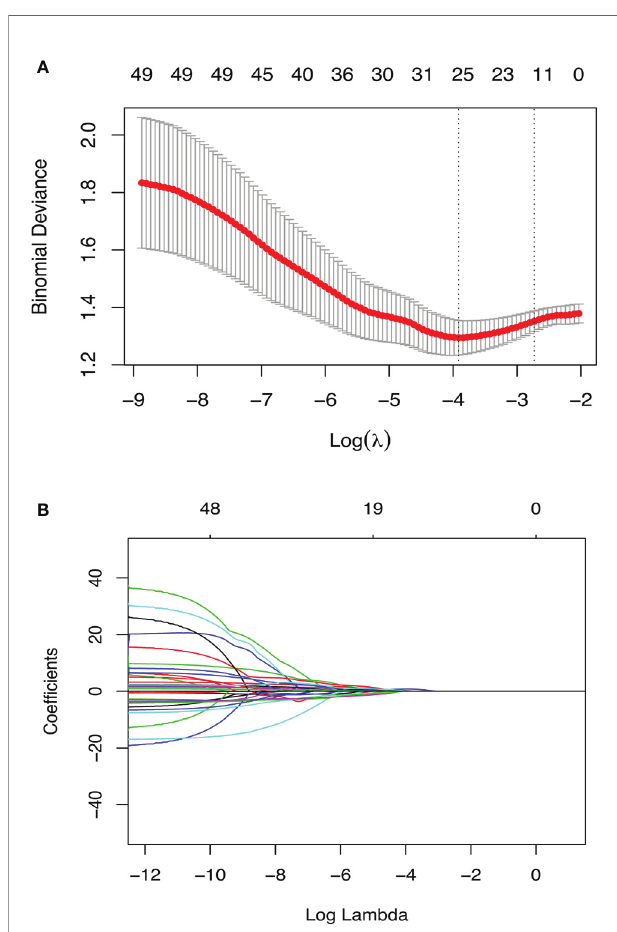
FIGURE 1 | Radiomics feature selection using the penalized logistic regression model with LASSO penalty. (A) The tuning parameter lambda( l ) selection with 10 folds cross-validation and binomial deviance curve was plotted against log( l ). The selected model was built with l min(0.020), equivalent to log( l ) = -3.92. (B) Lasso regression coef fi cients pro fi le. Coef fi cients are plottted against log( l ) depicting the trend of approaching zero as l increase.